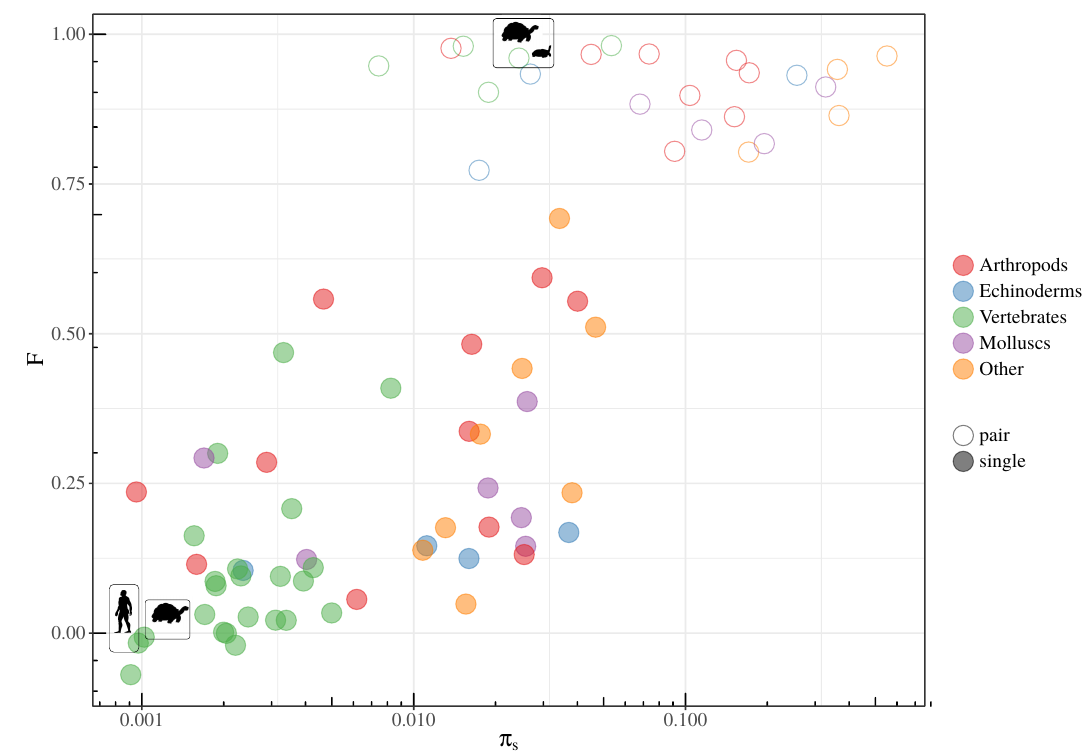
Figure 1 – Each filled circle corresponds to a single species of animals in which the tran- scriptome of at least four individuals was sequenced (Perry et al., 2012; Romiguier, Gayral, et al., 2014). Harvest ant Messor barbarus was excluded due to its highly specific mating system (Romiguier, Fournier, et al., 2017). Each open circle corresponds to a pair of con- generic species of animals in which the transcriptome of at least five individuals was sequenced (Galtier, 2016). Genotypes were called using the improved, contamination- aware algorithm of Ballenghien et al. (2017), parameter γ being set to 0.2. X-axis (log scale) reflects the amount of neutral genetic variation within the sample. This is measured by the synonymous-site heterozygosity, π S , for single species, and by the proportion of fixed synonymous differences for species pairs. Y-axis reflects the detected amount of population substructure, measured by the F statistics. The positions in the graph of C. nigra , Homo sapiens (single species) and of the C. nigra/Chelonoidis carbonaria pair are in- dicated by